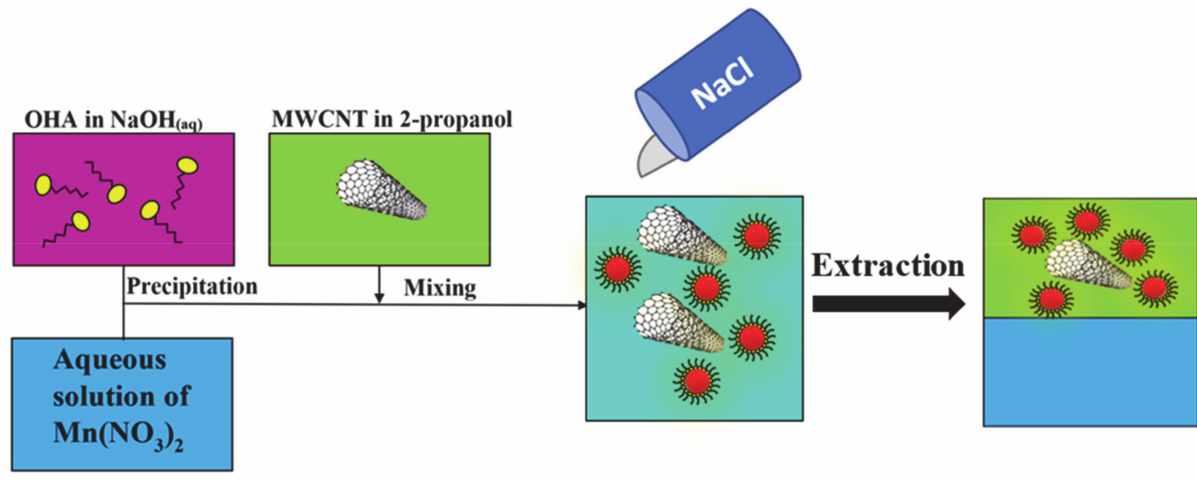
Figure 2. Schematic of Mn 3 O 4 synthesis, mixing with multiwalled carbon nanotube (MWCNT), and salting-out method.